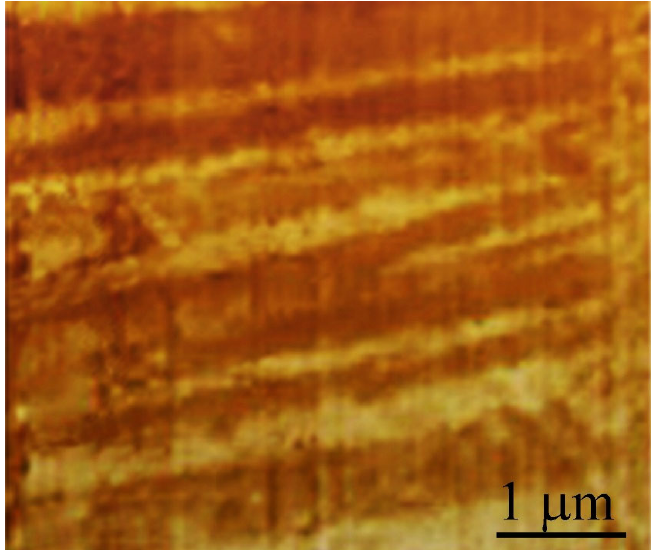
Figure 17. Maps of distribution of mechanical properties for Peak Force = 0.85 μ N.